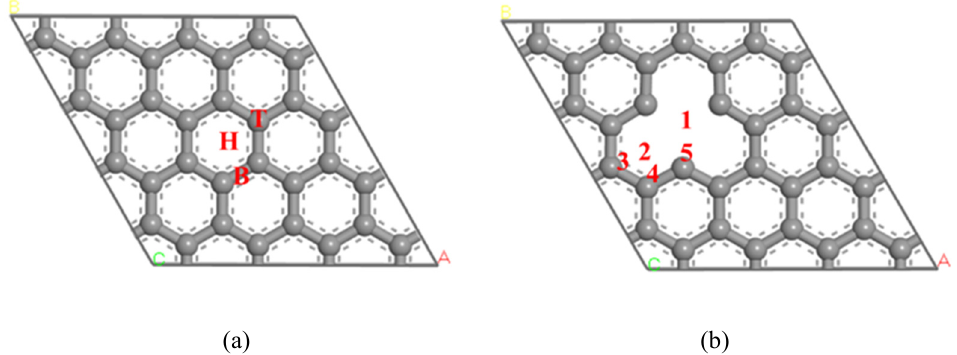
Figure 1. The structure graphene: ( a ) pristine graphene; ( b ) defect graphene.